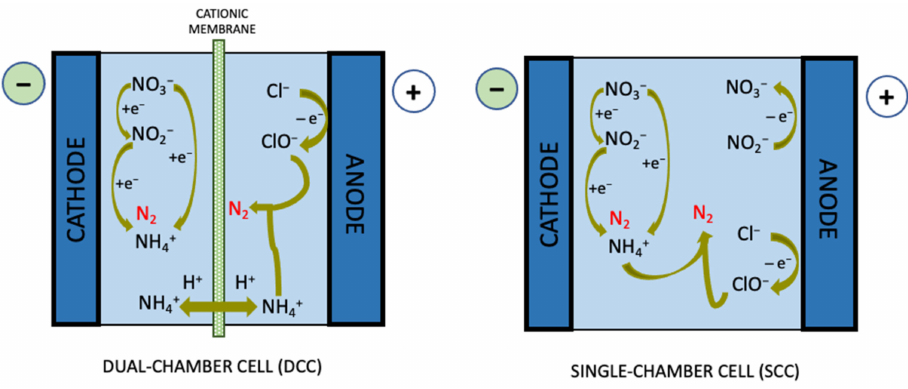
Figure 9. Electrochemical reduction of nitrate ions, in presence de Cl − , in dual- and single-chamber cells. In SCC configurations, chloride ions (Cl − ) are oxidized on the anode to hypochlorite (ClO − ), which reach ammonium ions directly in the solution (Figure 9). The presence